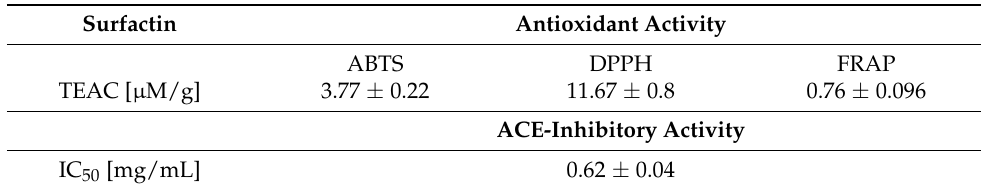
Table 3. The antioxidant and angiotensin-converting enzyme (ACE)-inhibitory activity of surfactin secreted by B. subtilis